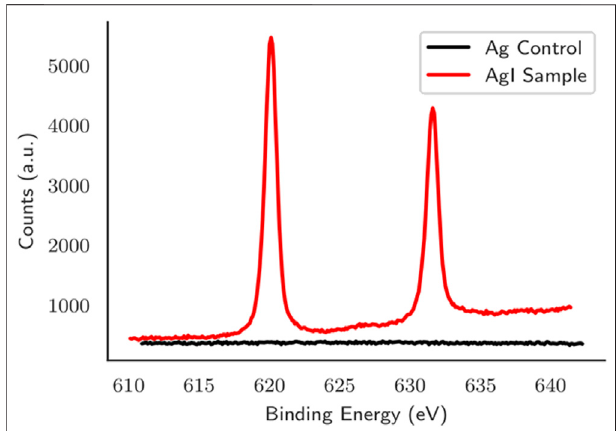
FIGURE 5 | XPS spectra of the iodine 3d 5/2 and 3d 3/2 core levels in silver-based ASN devices exposed to (sample, red) and not exposed to (control, black) iodization procedures. The two peaks at 620 and 631 eV correspond to the expected I − bands for I 3/d7